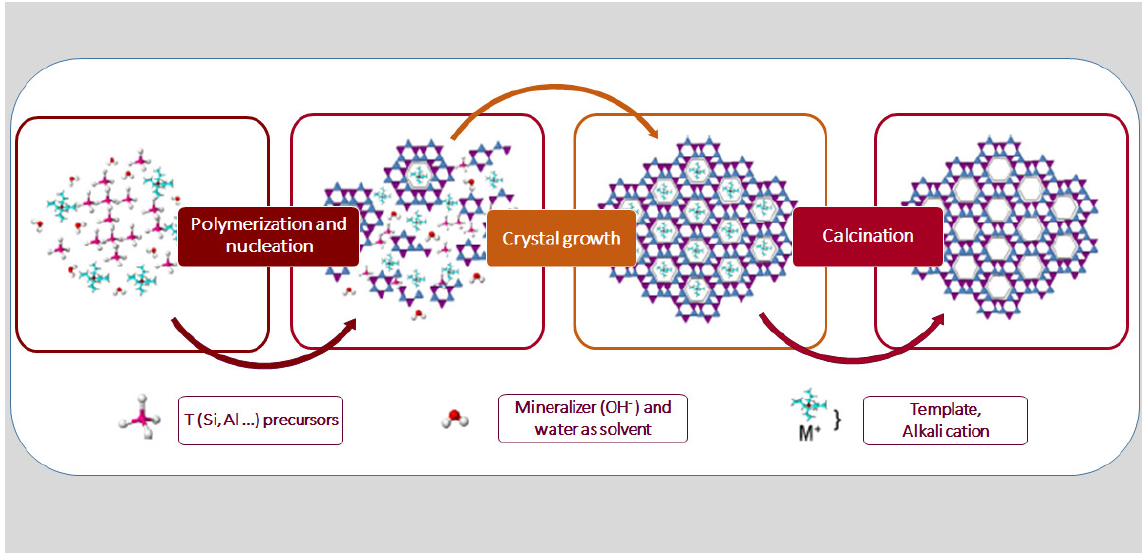
Figure 5. General scheme of zeolite synthesis (adapted from [59]).